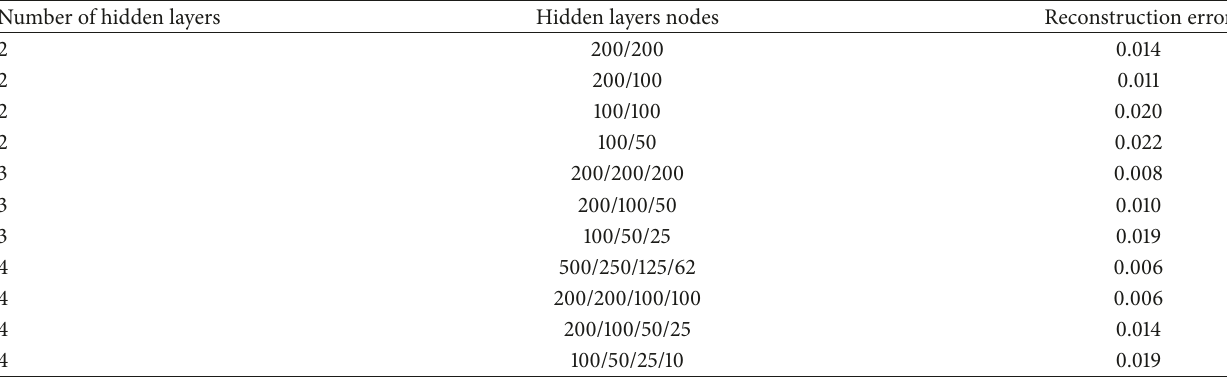
Table 3: Reconstruction of SSAEs with different numbers of hidden layers and hidden nodes.